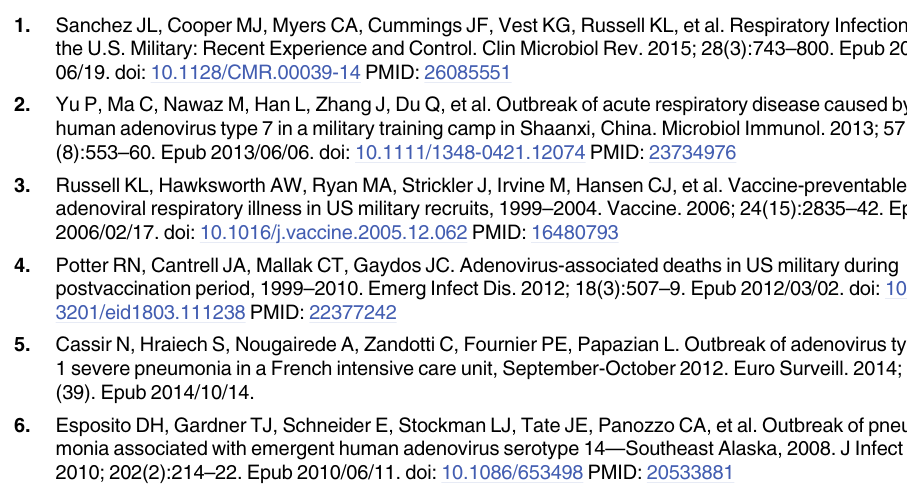
S2 Table. Chest computed tomography (CT) scan patterns of adenoviral pneumonia and number of days from fever onset to CT scan (n = 152). S3 Table. Comparison of clinical features associated with severe adenovirus pneumonia and mild to moderate adenovirus pneumonia among military personnel. S4 Table. Comparison of laboratory findings and outcomes associated with severe adeno- virus pneumonia and mild to moderate adenovirus pneumonia among military